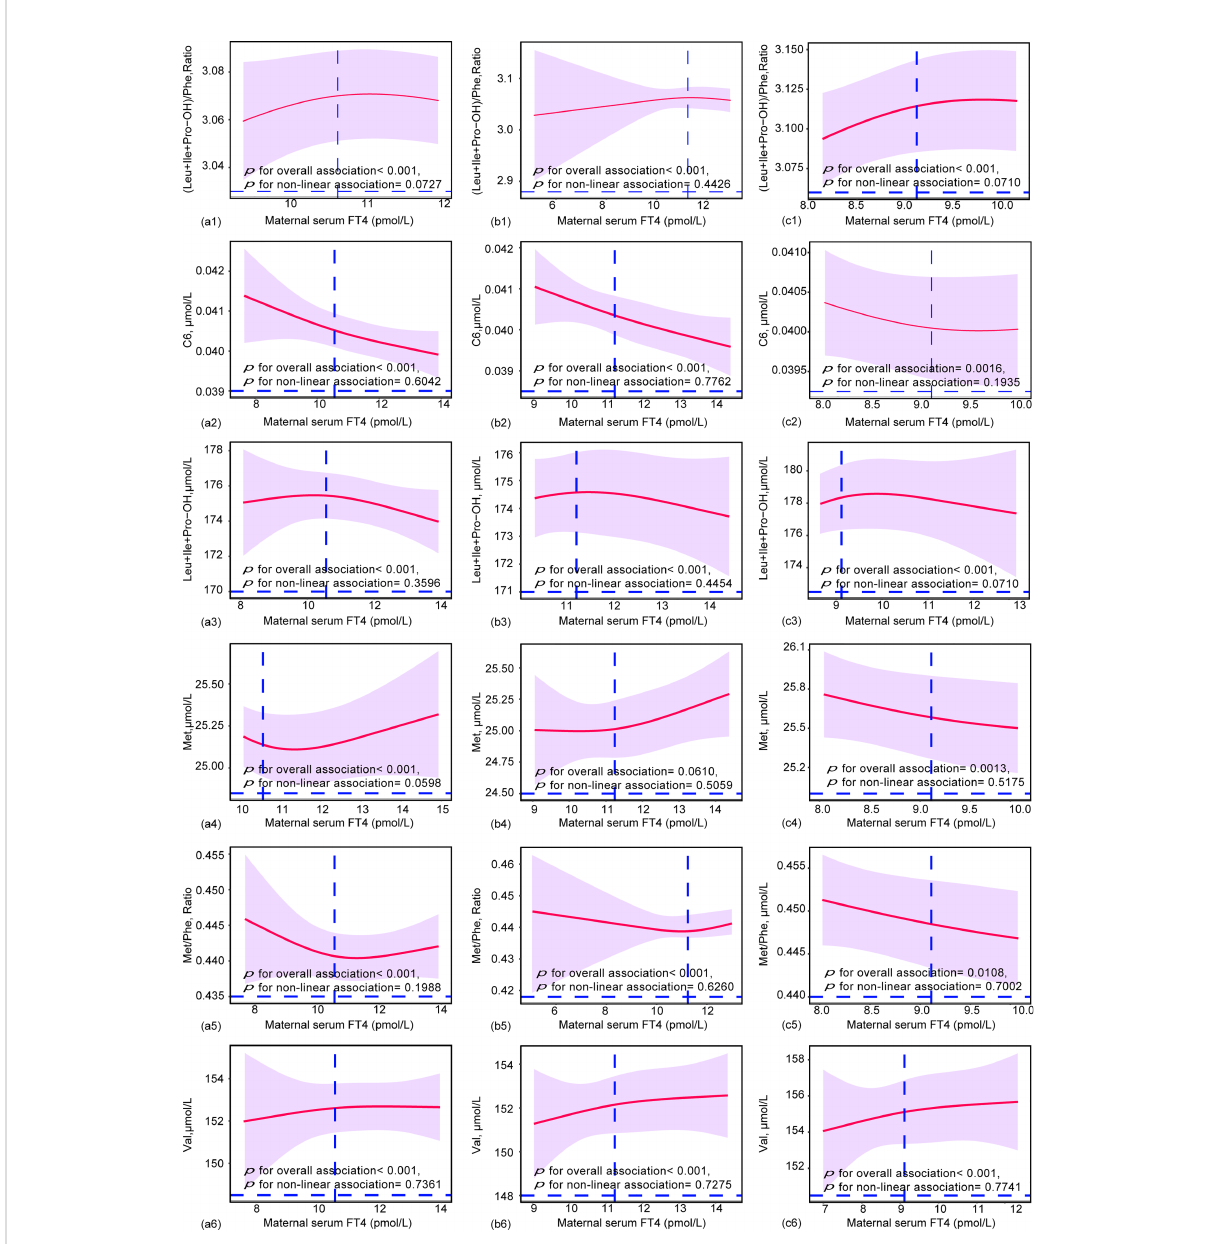
FIGURE 4 Restricted cubic spline (RCS) regression analysis for the maternal FT4 and neonatal metabolites during (a) (1-5) overall pregnancy, (b) (1-5) at the fi rst trimester, or (c) (1-5) at the second and third trimesters. Neonatal metabolites included were selected by GLM models. The median concentrations of maternal TSH were 10.56 pmol/L during overall pregnancy, 10.25 pmol/L at the fi rst trimester and 9.11 pmol/L at the second and third trimesters. RCS analysis was performed with adjustment by the age of pregnant women, gestational